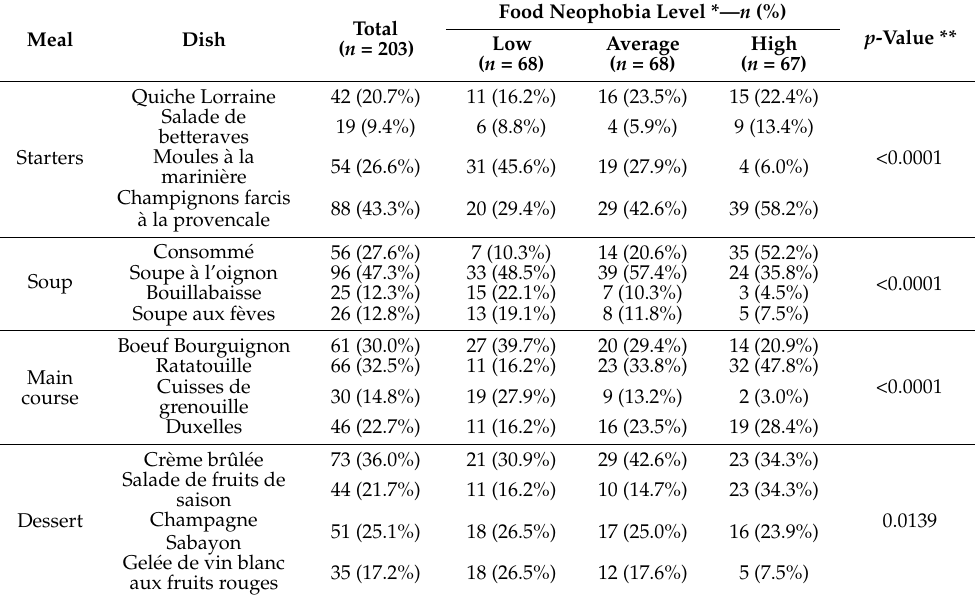
Table 4. The dish choices made by the studied sample of young Polish women from the model French restaurant menu, stratified by the level of food